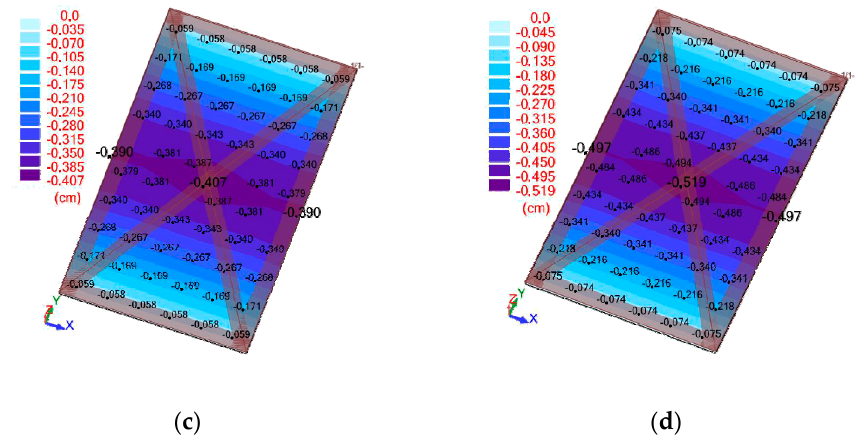
Figure 12. Map of deflections corresponding to the loading force: ( a ) 10 kN; ( b ) 15 kN; ( c ) 20 kN and ( d ) 25 kN.